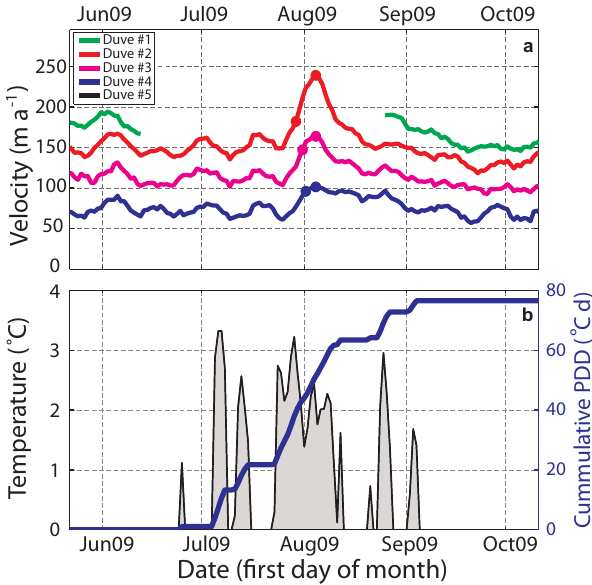
Fig. 6. Summer speed-up along the central flowline of Duvebreen in summer 2009 (a) with markers indicating the occurrence of on- set of summer speed-up and peak velocity. Positive daily mean air temperature and cumulative PDD is shown in (b)